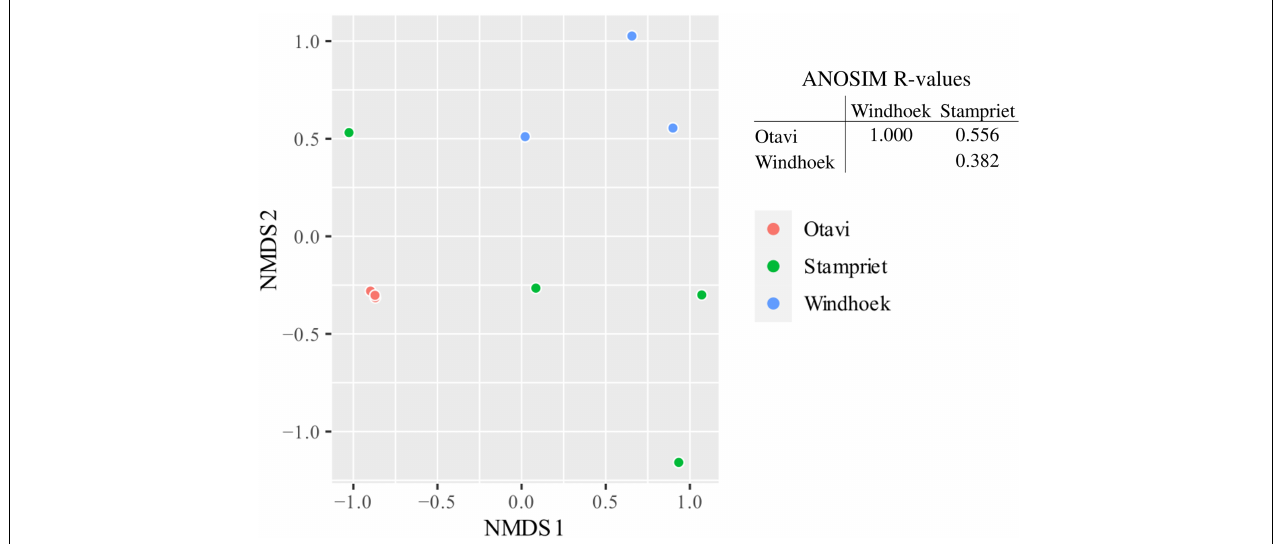
FIGURE 2 | Non-metric multidimensional scaling (NMDS) ordination of sampled S. dumicola microbiomes and analysis of similarities (ANOSIM) of microbiome data. For microbiome composition, see Supplementary Figure 1 . NMDS ordination is based on Bray-Curtis dissimilarities. Each point is an individual spider’s microbiome representing a nest of the respective populations (Otavi in red, Stampriet in green and Windhoek in blue). The ANOSIM analysis is based on Bray-Curtis dissimilarities and indicates the degree of difference between populations; R = 0 indicates no difference in microbiome composition between populations and R = 1 indicates a high degree of difference in microbiome composition between populations. Between populations, there was no significant difference ( p > 0.05) in microbiome